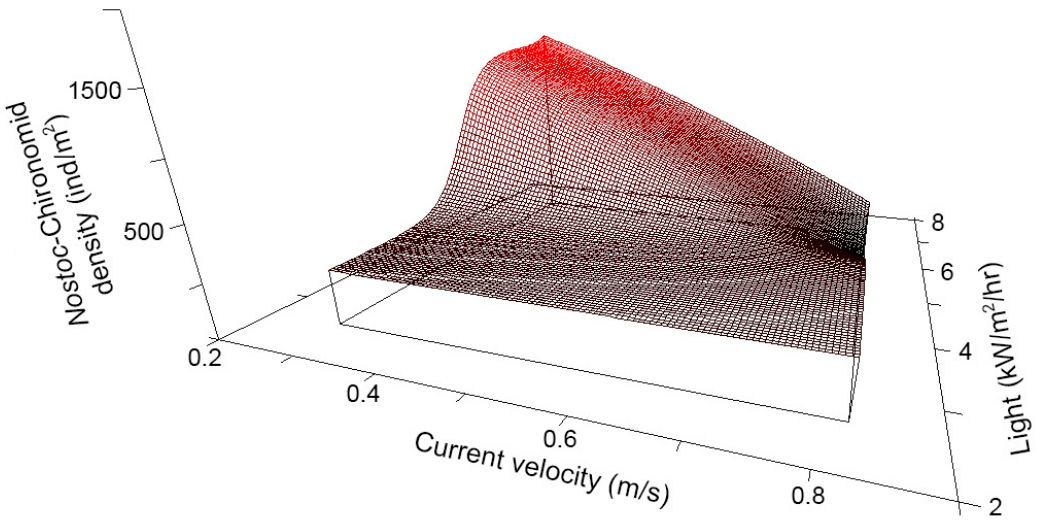
Figure 4. Nonparametric multiplicative regression (NPMR) modeled Chironomid- Nostoc mutualist density versus current velocity and light availability. Model is based on density data from 20 Surber samples collected in 2006 and explains 92% of the variation in the empirical data.